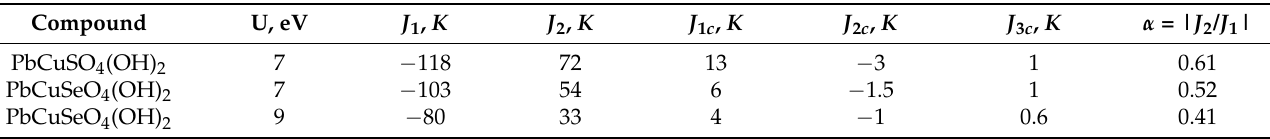
Table 3. The exchange interaction parameters (in K) calculated within GGA+U for PbCu(SeO 4 )(OH) 2 and PbCu(SO 4 )(OH) 2 . The notations J 1 c , J 2 c and J 3 c correspond to the NN, NNN and NNNN interchain exchange interactions